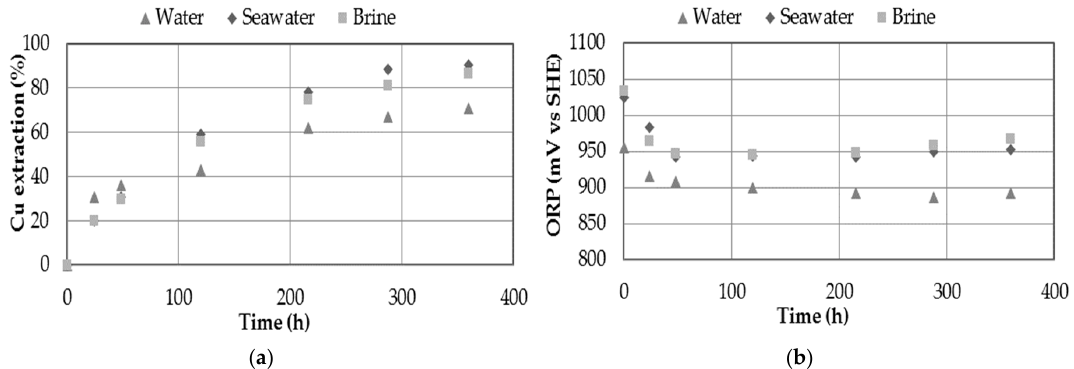
Figure 5. ( a ) Copper extraction (%) vs, time (h) at di ff erent water sources: water, seawater and brine. ( b ) Redox potential (mV) vs. time (h) at di ff erent water sources: water, seawater and brine. Experimental conditions: [NaNO 3 ] = [H 2 SO 4 ] = 0.7 M, 45 °C and sample A.